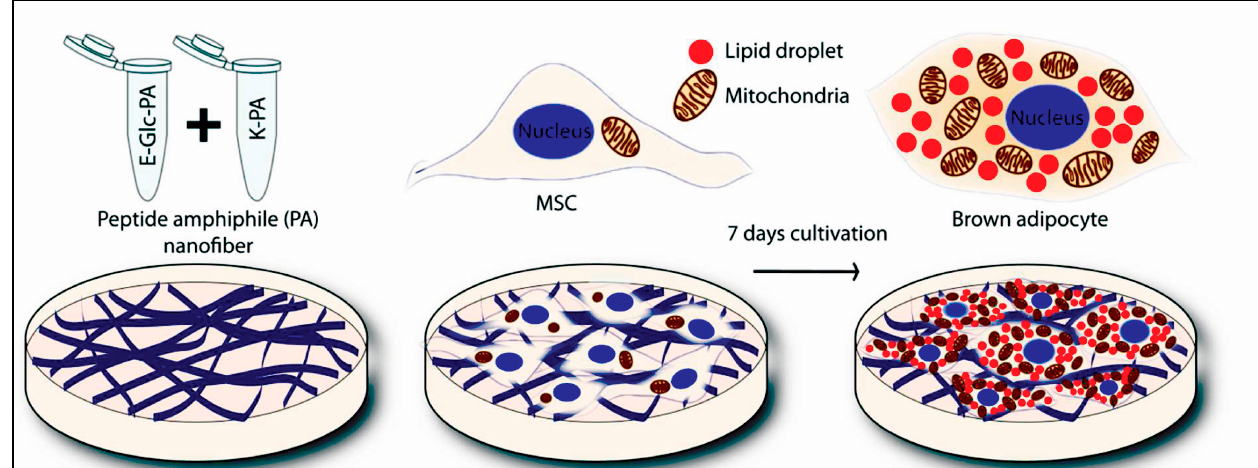
Figure 13. Schematic representation of supramolecular glycopeptide nanofibers for MSCs differentiation into brown adipocytes. Reprinted with permission from Ref. [278], Copyright 2017, American Chemical Society.